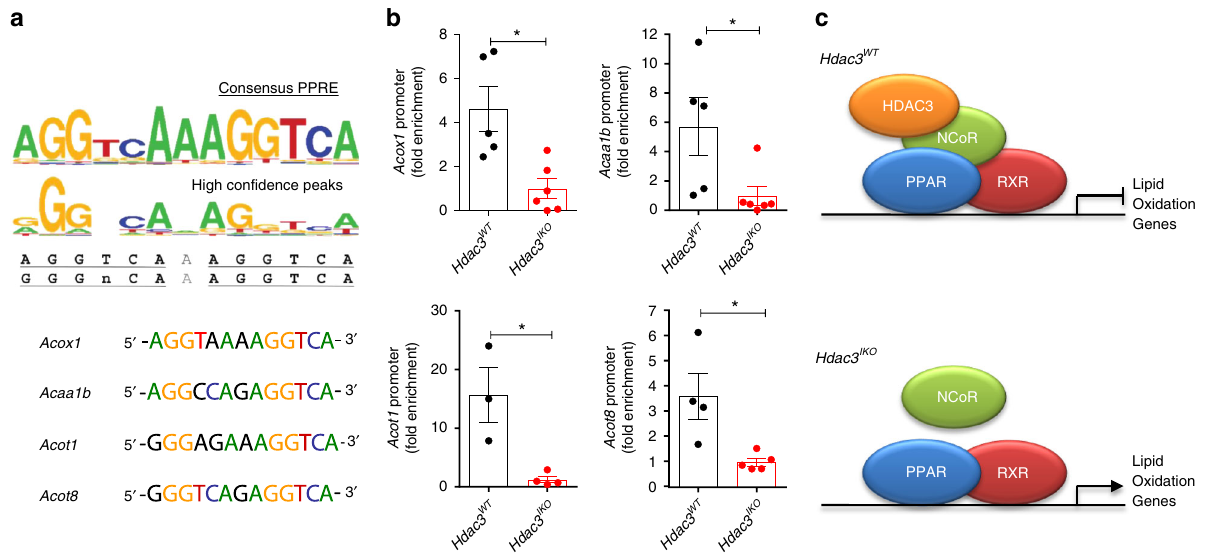
Fig. 6 HDAC3 regulates expression of PPAR-target genes. a Identi fi cation of putative PPAR response elements (PPREs) in the promoters of Acox1, Acaa1b, Acot1 and Acot8 , and comparison to the consensus PPRE. Consensus PPRE obtained from the JASPAR database 56 . b Chromatin immunoprecipitation (ChIP) analysis of HDAC3 occupancy at these putative PPREs in IECs isolated from 4 – 6-week-old Hdac3 WT and Hdac3 IKO male mice fed a standard chow diet. Values shown are mean + SEM of ChIP experiments performed on enterocytes from n = 6 biological replicates with outliers removed (see source data fi le), * P < 0.05, ** P < 0.005, unpaired t test. c Model of de-repression of fatty acid oxidation genes in Hdac3 IKO mice.